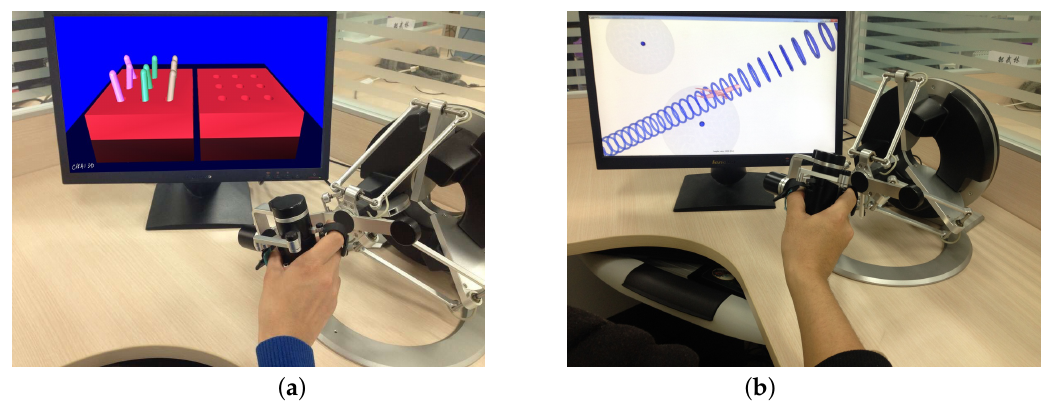
Figure 9. Warming-up exercises with ( a ) the nine peg insertion virtual scenario; and ( b ) the flying through a spatial pathway virtual